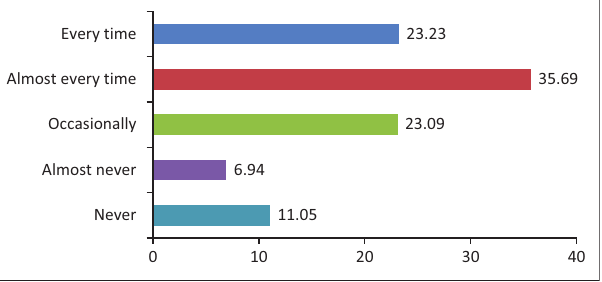
FIGURE 6: Establishing lines of communication in relation to the